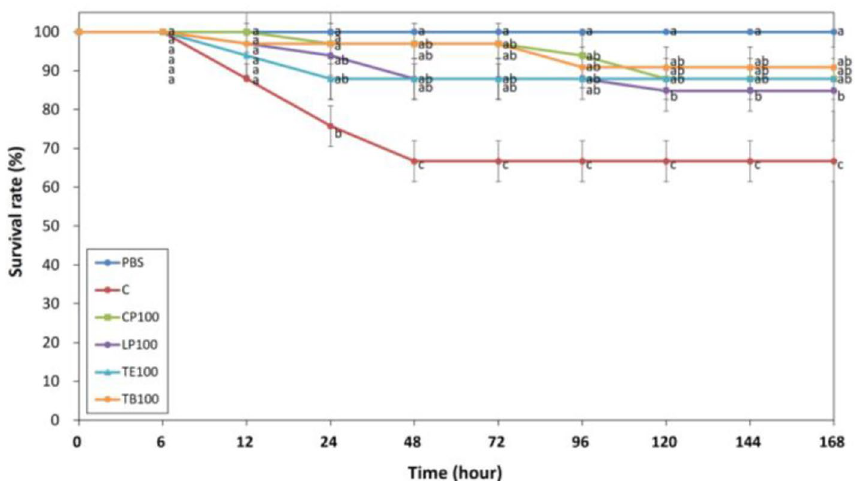
Figure 7. Effects of dietary AST on white shrimp resistance to V. parahaemolyticus. Survival rate (%) of white shrimp fed diets containing AST for 7 days after injections with V. parahaemolyticus . One-way ANOVA and Tukey’s test were performed to compare the differences between groups at indicated time point. Significant differences ( p < 0.05) between groups are indicated by different letters above the time points. The data are expressed as mean ± standard deviation (n =